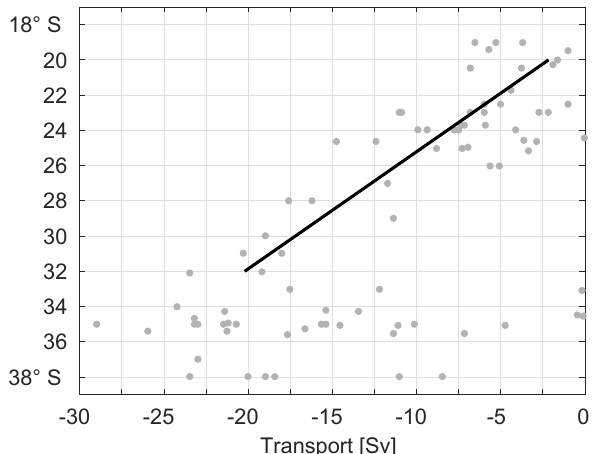
Figure 1. Previously published estimates of the Brazil Current transports as a function of latitude. The line with a slope of about 1.6Sv per degree is a fit to the transports measured in 19 to 32 ◦ S. The sources of the transport estimates are Fisher (1964), Signorini (1978), Miranda and Castro Filho (1979), Miranda and Castro Filho (1981), Evans et al. (1983), Evans and Signorini (1985), Gordon and Greengrove (1986), Garzoli and Garraffo (1989), Gordon (1989), Stramma (1989), Garfield (1990), Peterson (1990), Stramma et al. (1990), Zemba (1991), Garzoli (1993), Campos et al. (1995), Maa- maatuaiahutapu et al. (1998), Müller et al. (1998), Jullion et al. (2006), Mata et al. (2012), Garzoli et al. (2013), and Biló et al.